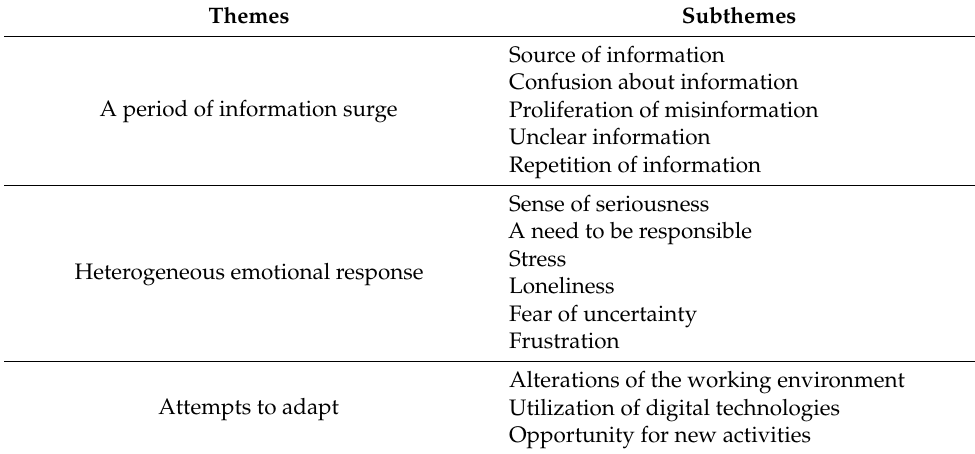
Table 2. The participants’ perception of the implementation of the